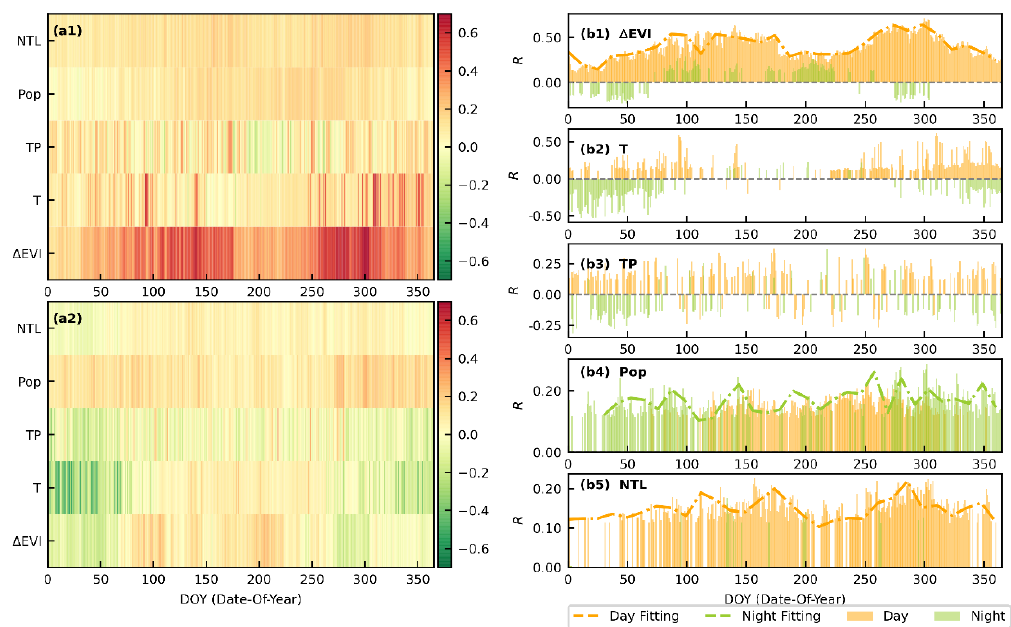
Figure 9. Relationships between SUHII and potential factors at a daily scale. The heat maps represent their correlation at daytime ( a1 ) and nighttime ( a2 ). The bar charts ( b ) show a diurnal contrast of their relationships in terms of each factor (( b1 ) for ΔEVI, ( b2 ) for T, ( b3 ) for TP, ( b4 ) for Pop, ( b5 ) for NTL). To make the results clear, the correlation with a p -value less than 0.05 is shown in the bar charts. The fitting lines are employed to clearly show the annual variations in their correlation, where days with p -values less than 0.05 are found to be over 270 during a year.